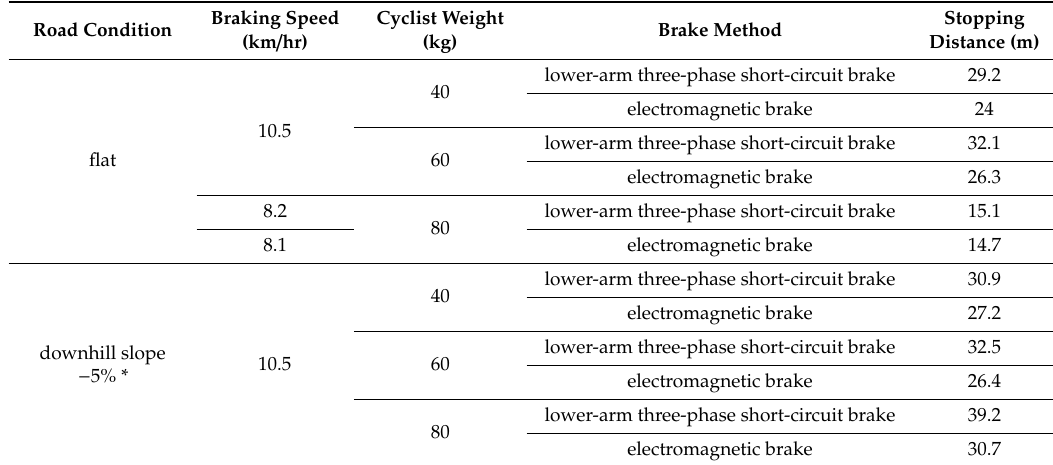
Figure 21. Results for road slope − 5%, cyclist weight 80 kg, and electromagnetic reversal braking. Table 3. Experimental results under various conditions